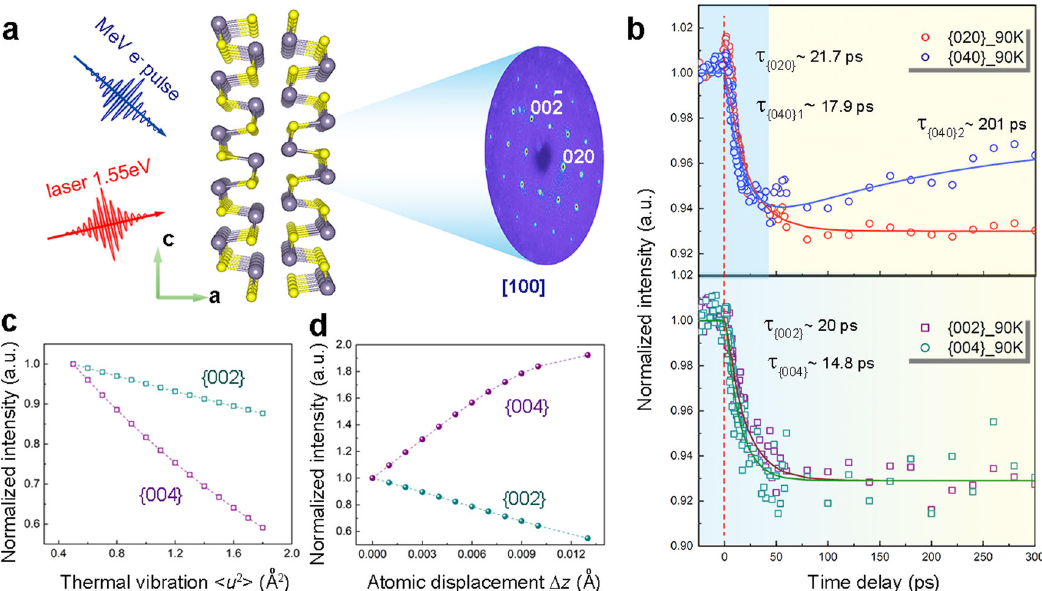
Fig. 1 UED experimental setup and observations. a Schematic of the ultrafast laser-pump electrons-probe setup to study photoinduced lattice dynamics in SnSe. The crystallographic axes are labeled. b Temporal evolution of the normalized diffraction intensity I / I 0 of Bragg peaks {020}, {040}, {002} and {004} at 90 K. The solid lines are fi ts of {020}, {002} and {004} using a single-exponential function; the solid line for the {040} peak intensity is fi tted to a double-exponential function. The time constant for each plot is inserted. c , d Normalized intensity calculated based on structure factors as a function of thermal vibration < u 2 > ( c ) and atomic displacement Δ z for {002} and {004} re fl ections ( d